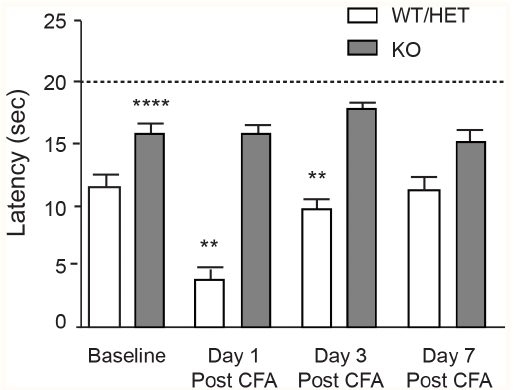
Figure 5. Nav1.7 KOs do not develop CFA-induced thermal hyperalgesia. Latency time to withdrawal from radiant heat stimulus for Nav1.7 KO (n=4) and WT/HET littermates (n=9) at baseline and 1, 3, and 7 days following CFA injection. WT/HET mice developed robust hyperalgesia in the affected paw 24 hours post-CFA injection that returned to baseline at day 7. KO mice did not develop hyperalgesia. Differences between KO and WT/HET were statistically significant at baseline (WT/HET = 11.5 sec 6 0.8 sec; KO = 16 sec 6 0.8 sec, p=0.0001), day 1 (WT/HET=4.0 sec 6 0.5 sec, KO=15.7 sec 6 0.9 sec, p , 0.0001) and day 3 (WT/HET=9.6 sec 6 1.0 sec, KO=17.8 sec 6 0.7 sec, p=0.0028), but not at day 7 (WT/HET=11.3 sec 6 1.1 sec, KO=15.3 sec 6 1.0 sec, p=0.5381), at which time control animals had recovered back to baseline (all values mean 6 S.E.M, ANOVA).